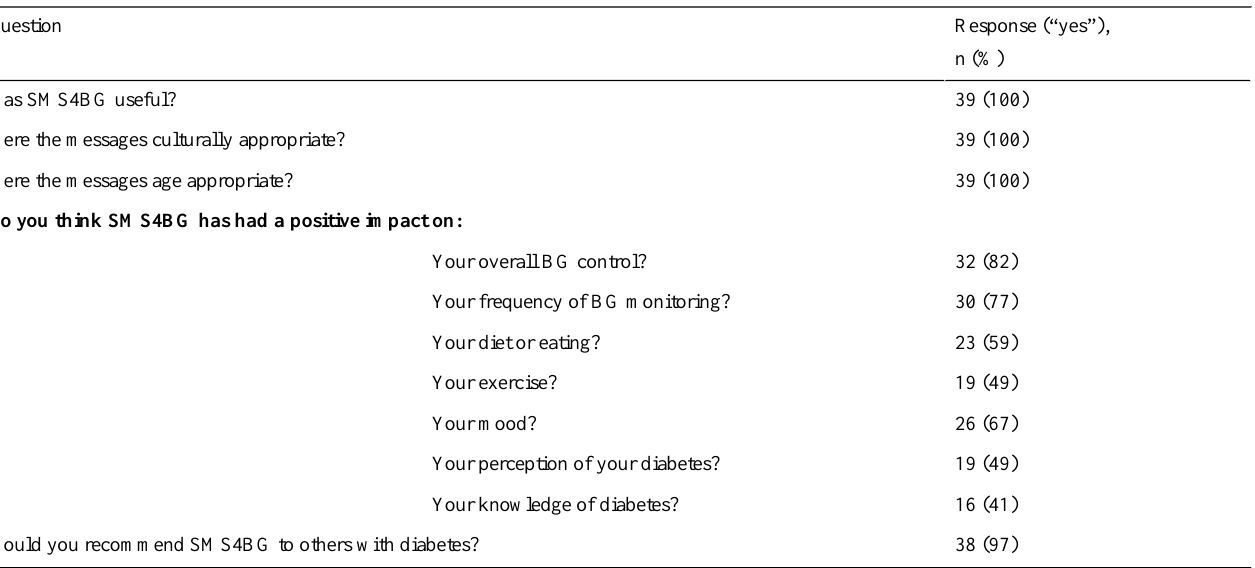
Table 4. Results of the follow-up interviews